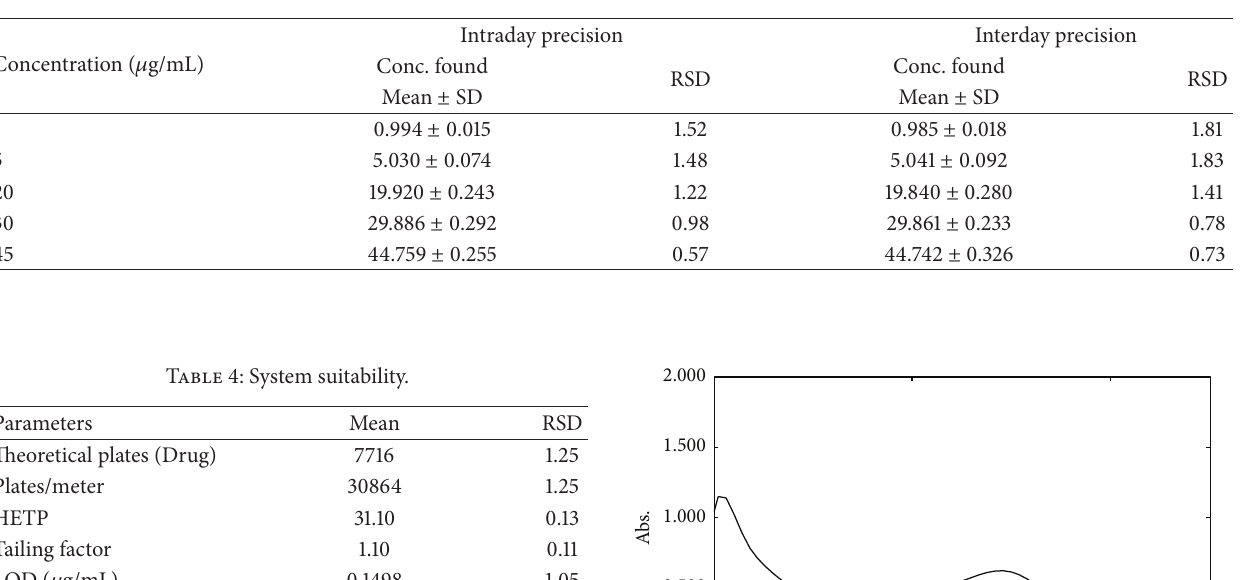
Table 3: Precision study of the proposed method.